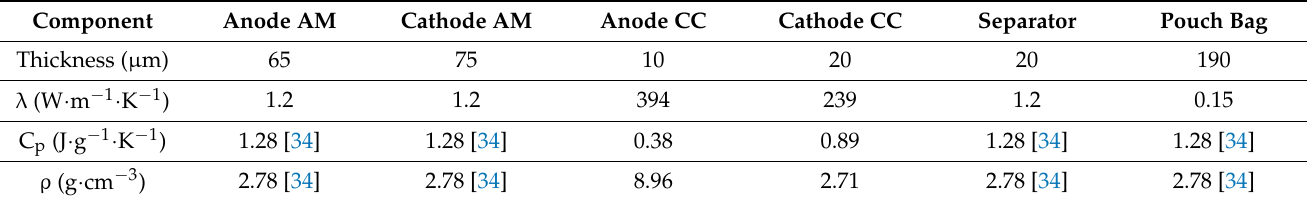
Table 1. Physical properties of the components contained in the cell and the thickness of its internal layers obtained by scanning electron